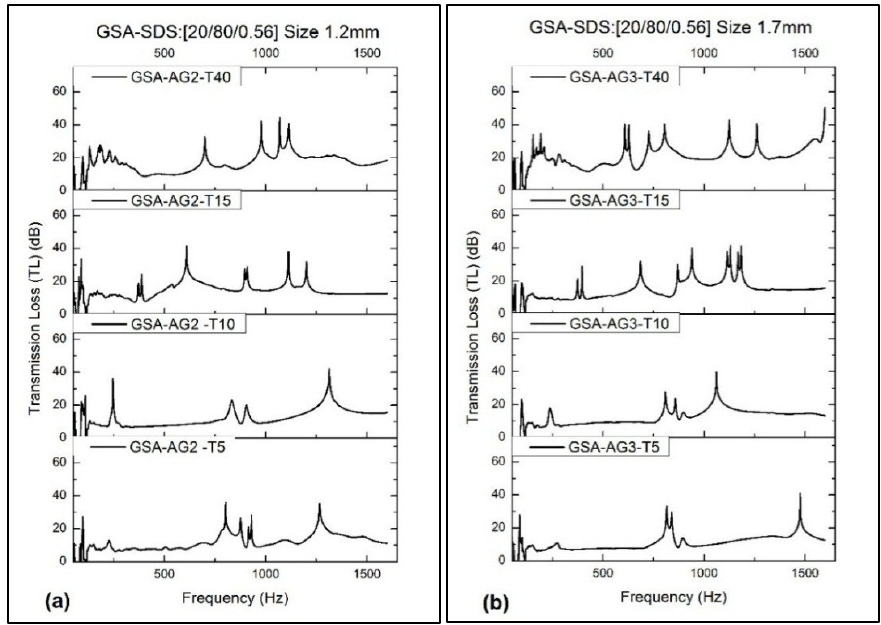
Figure 5. Transmission loss (TL)for GSA–AG2/AG3 composites’ thickness T5–T40 ( a ) size 1.2 mm; ( b ) size 1.7 mm.